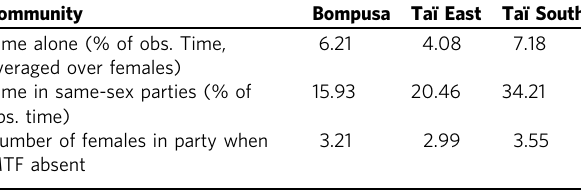
Table 2 Comparison of female association patterns one bonobo (Bompusa) and two chimpanzee communities (Taï East and Taï South).